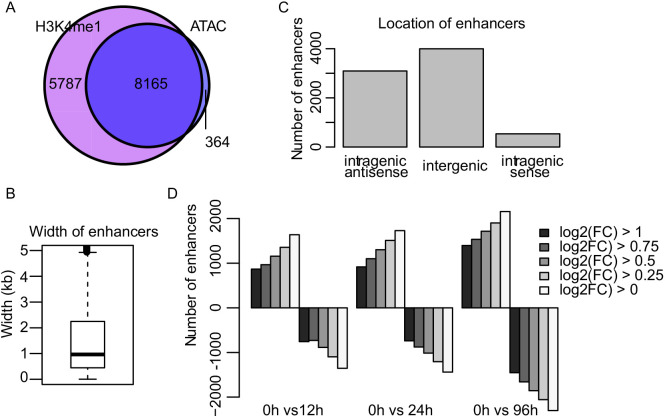
TT-seq identifies transcriptionally active enhancers.(A) Venn diagram of ncRNAs overlapping with H3K4me1 ChIP-seq or ATAC-seq signal. (B) Width of enhancers identified by TT-seq (Figure 2A and Materials and methods). (C) Location of identified enhancers. (D) Number of enhancers with differentially regulated synthesis levels at various cutoff levels of log2 fold change. (FDR < 0.05).